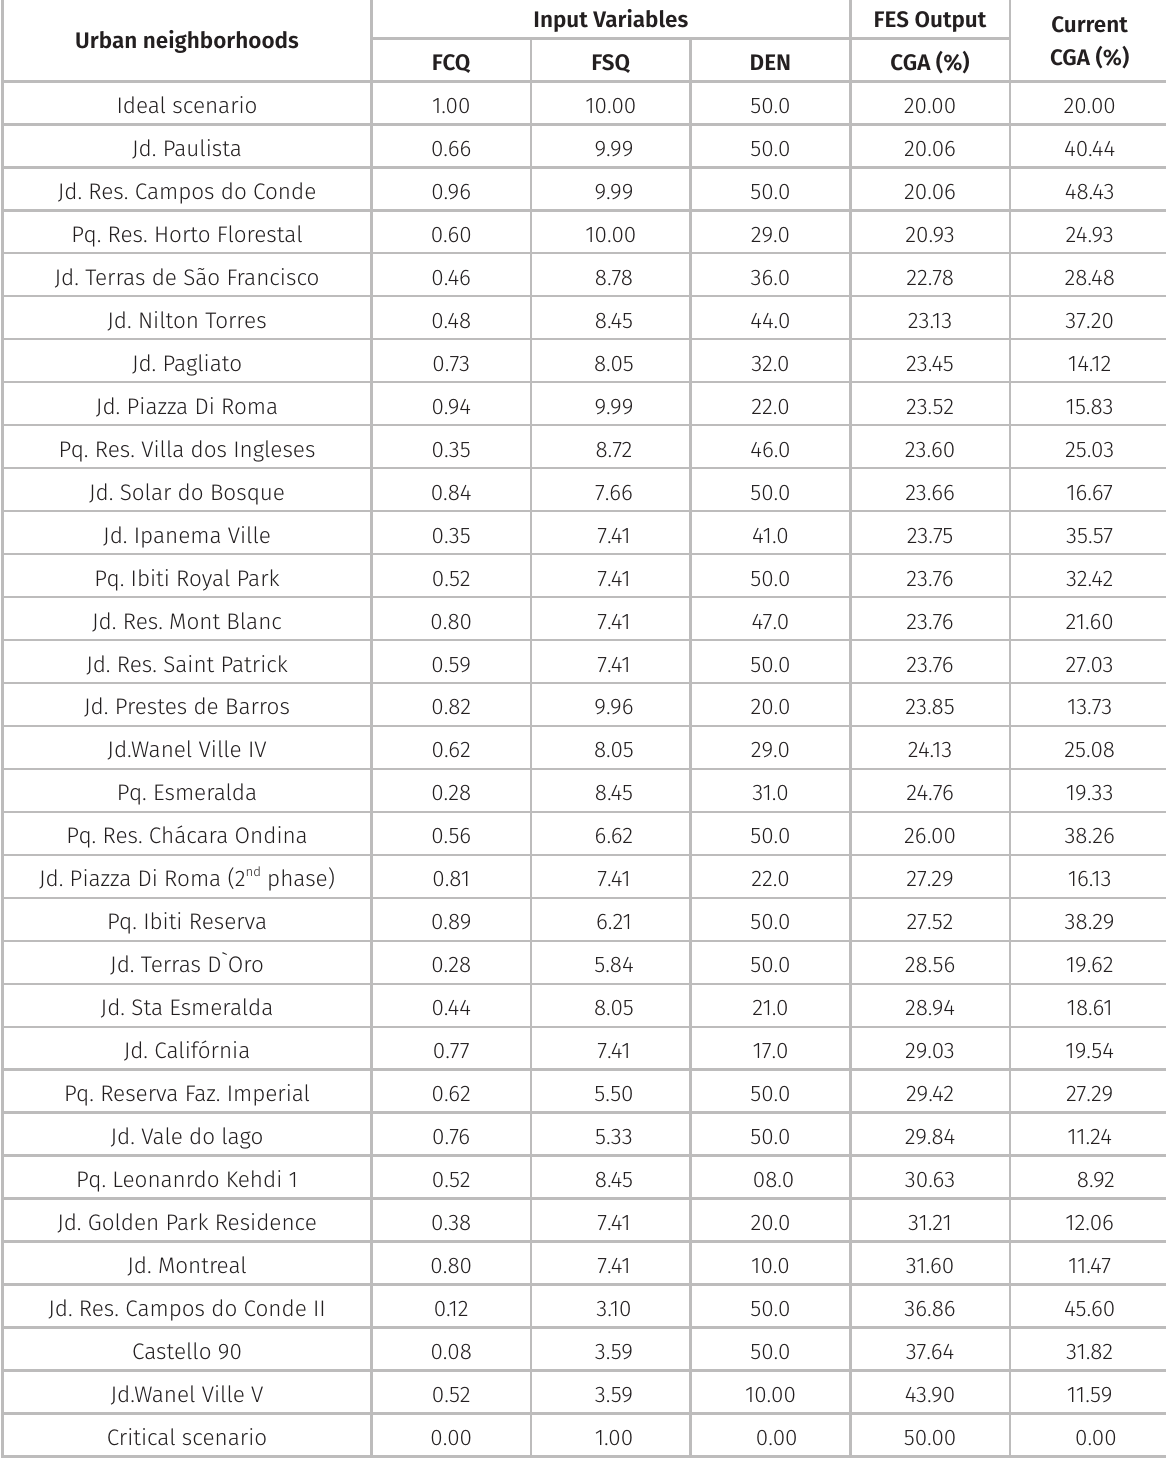
Table II. Green areas recommended as adequate by the fuzzy expert system (FES). Urban neighborhoods Ideal